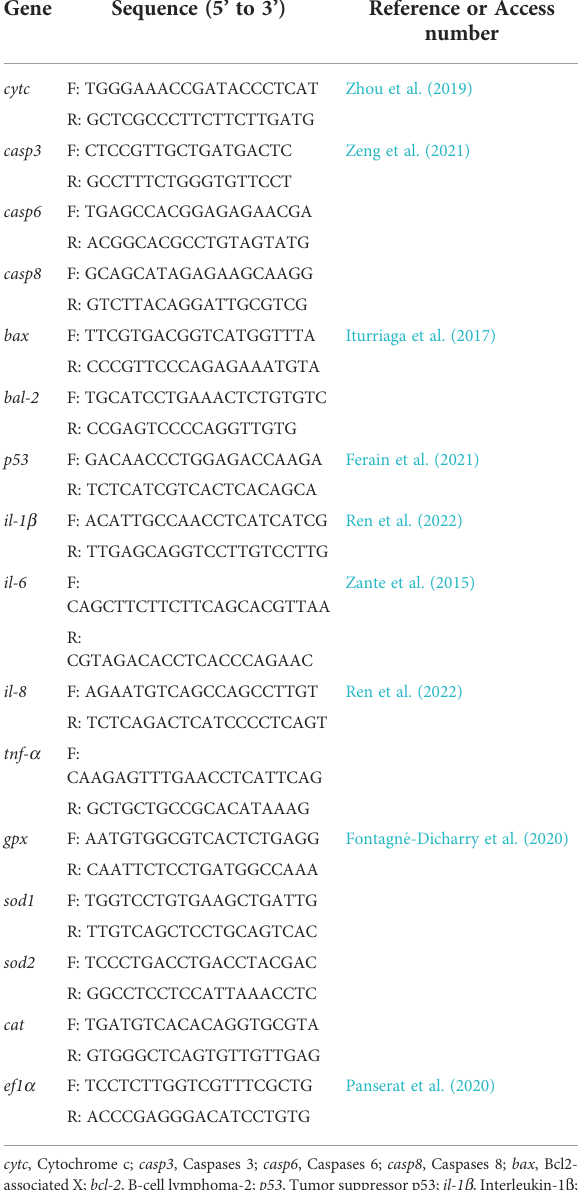
TABLE 1 The speci fi c primers used for real-time PCR in this study.